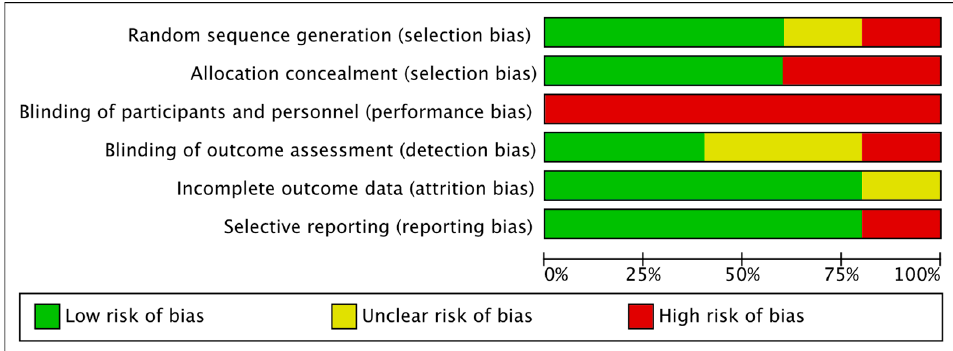
Figure 3. Overall risk of bias. The results are presented as percentages.